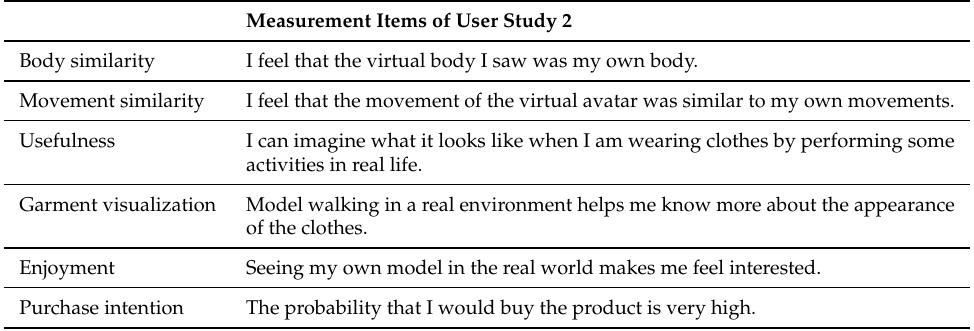
Table 5. Questionnaire and measurement